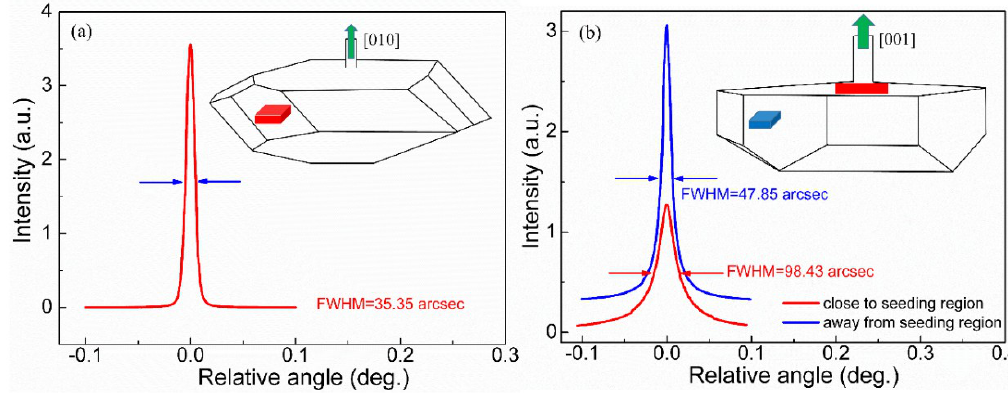
Figure 3. Rocking curves of the (010) wafers for α -BIBO ( a ) and (001) wafers for BZBO ( b ).